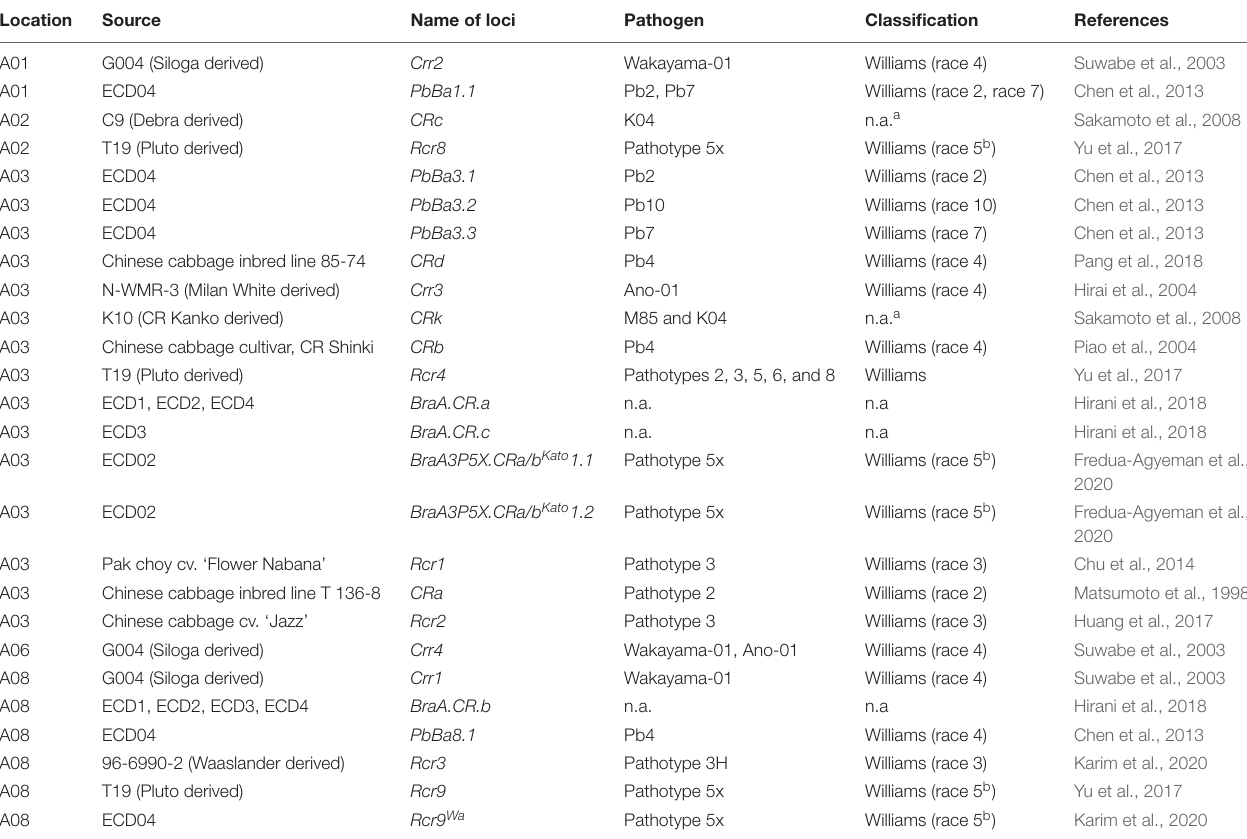
TABLE 3 | Clubroot-resistant loci presently known in Brassica rapa